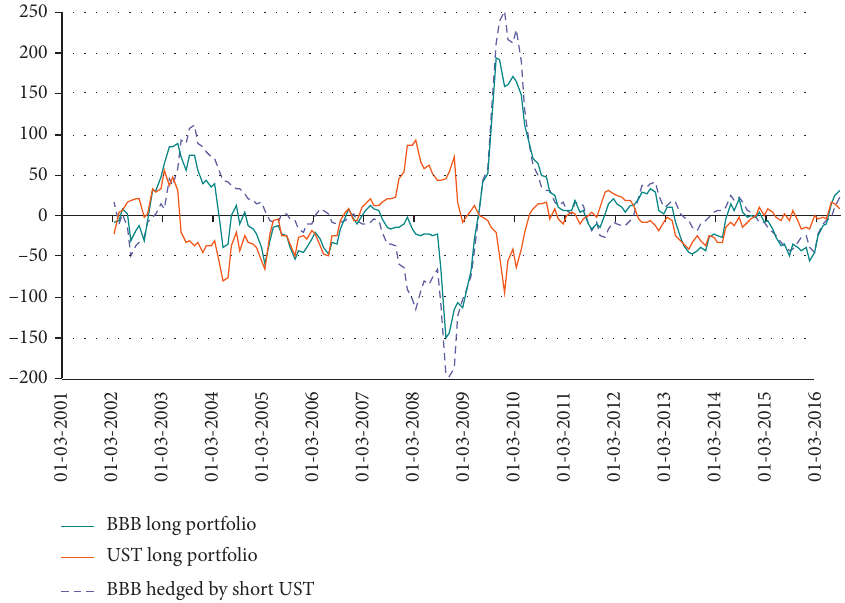
Figure 3: Yearly capital gains for the US BBB-rated, UST, and hedged